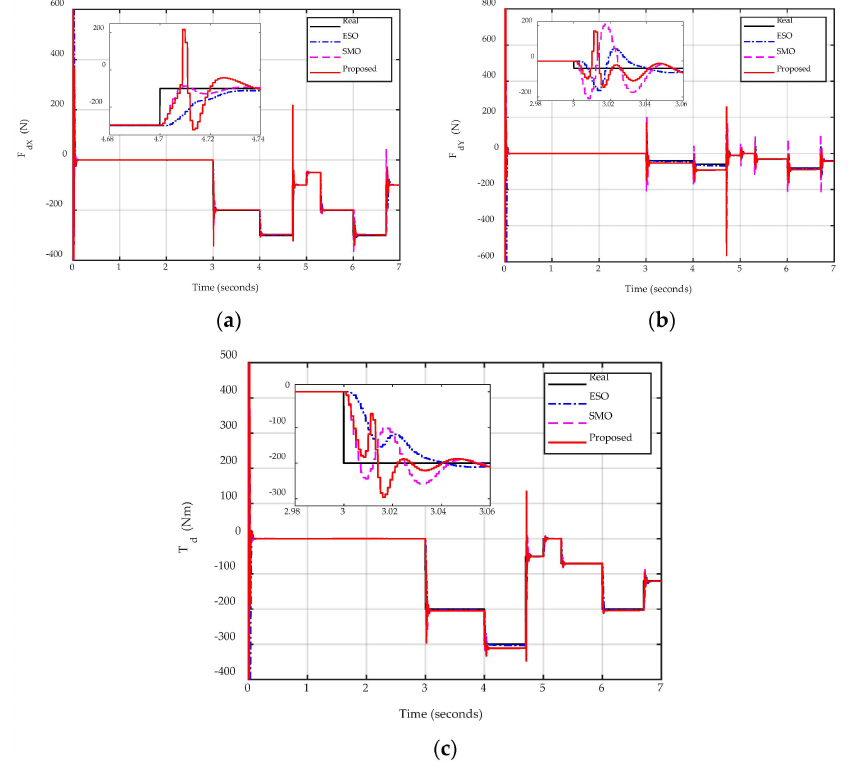
Figure 6. Estimation performance of ( a ) force disturbance in the x-direction, ( b ) force disturbance in the y-direction, and ( c ) torque disturbance in Case 1.